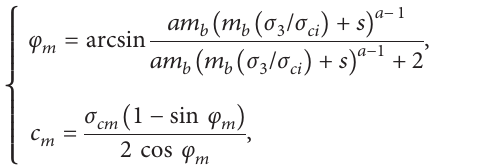
Figure 10: The change laws of c